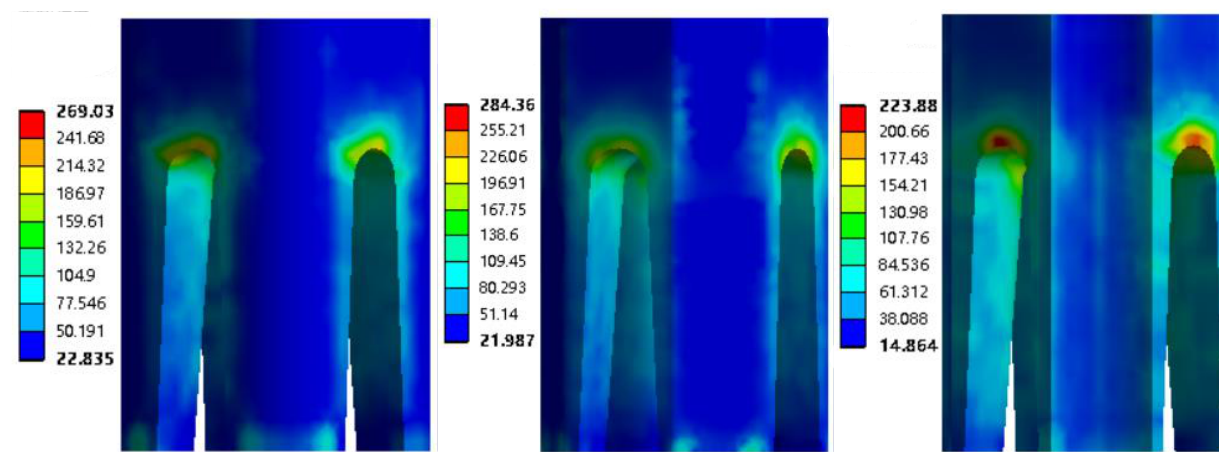
FIGURE 7. Schematic diagram of armature temperature distribution of different configurations